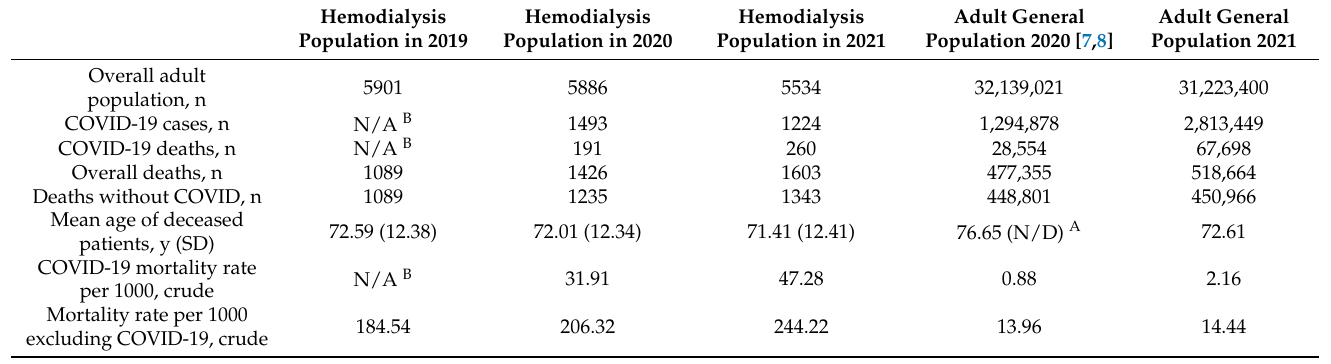
Table 1. Comparison of the mortality rate in hemodialyzed patients in 2019, 2020, and 2021 and in